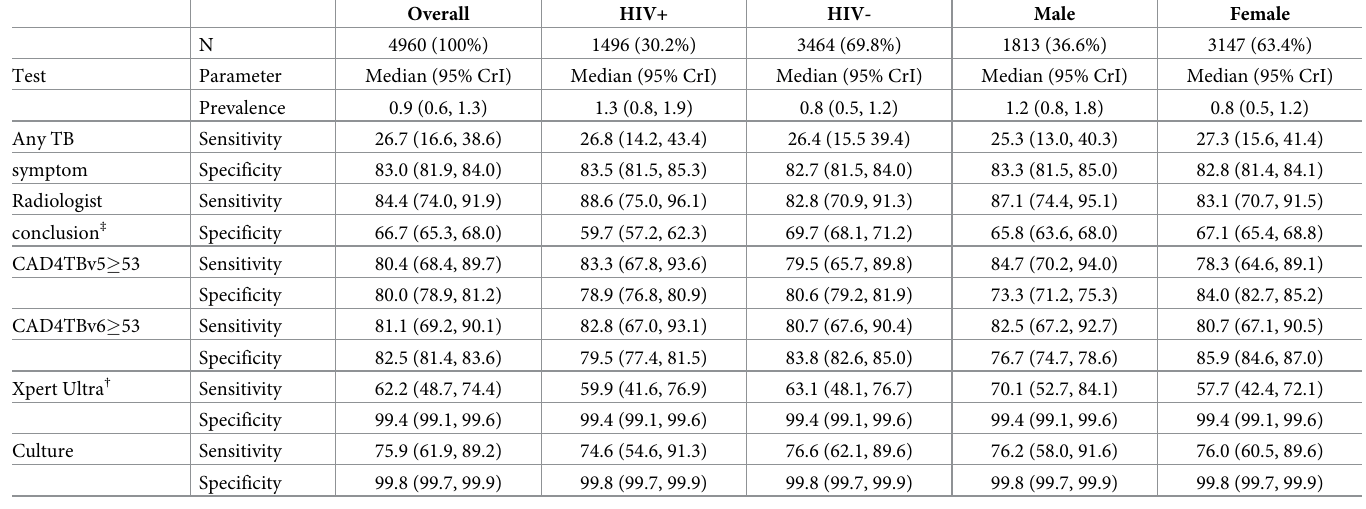
Table 4. Posterior median and 95% credible intervals (95% CrI) of PTB prevalence and diagnostic test sensitivity and specificity for Vukuzazi dataset adjusted for HIV status, sex and age, by HIV status adjusted for age and sex and by sex, adjusted for HIV status and